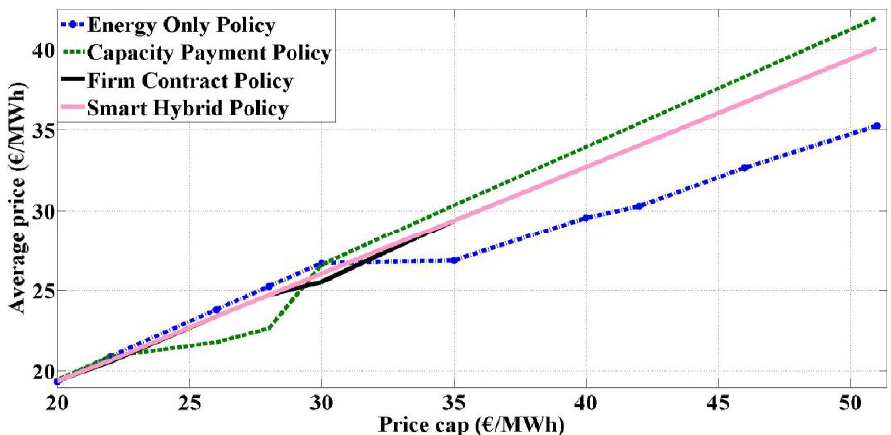
Figure 11. Market-clearing price as a function of price